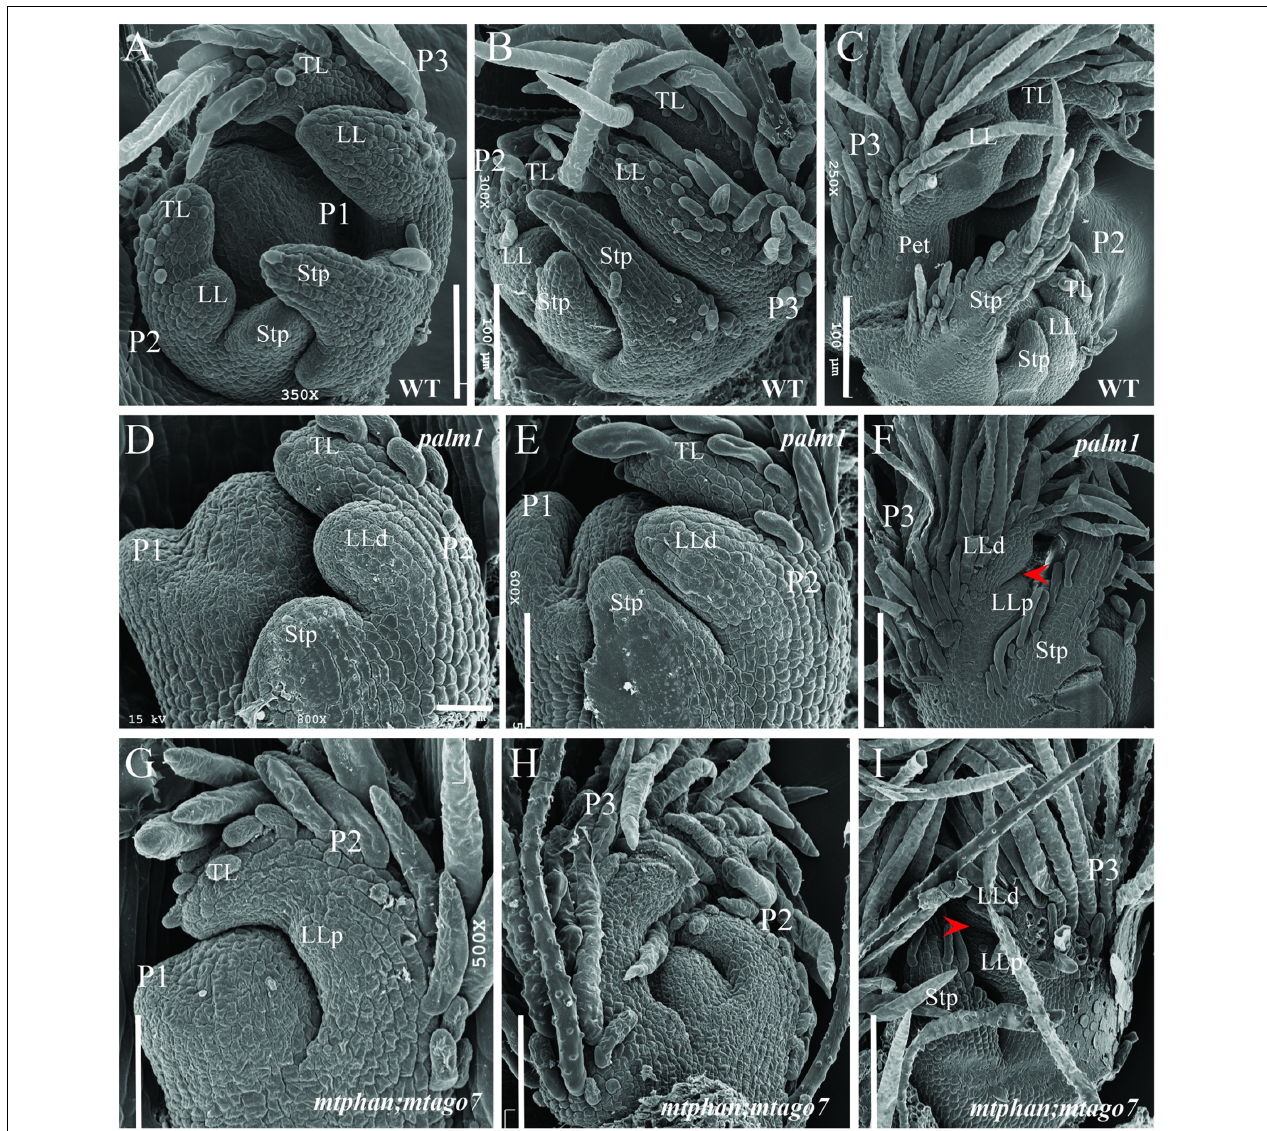
FIGURE 7 | Scanning electron microscopic analyses of leaf primordia development in WT, and palm1 and mtphan;mtago7 mutants. SEM images of leaf development in WT (A–C) , palm1 (D–F) , and mtphan;mtago7 (G–I) . Some trichomes were removed in order to view the boundary between LLd and LLp (I) . Arrowheads (F,I) denote the boundary between LLd and LLp. P, plastochron; TL, terminal leaflet; LL, lateral leaflet; Stp, stipule; LLd, distal lateral leaflet; LLp, proximal lateral